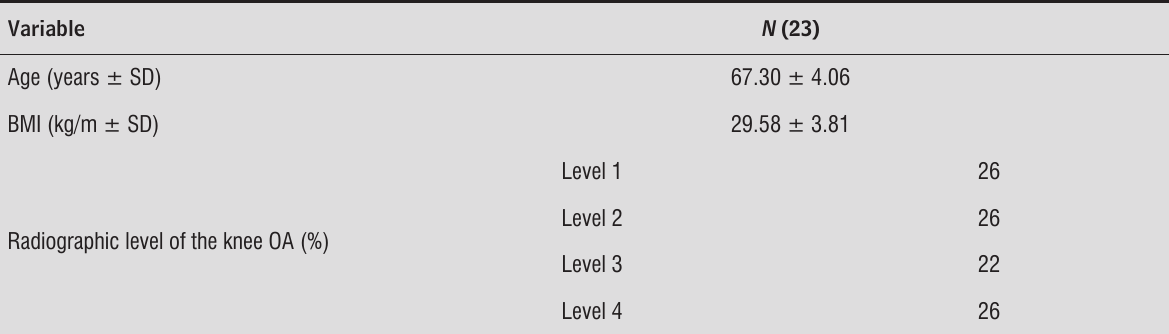
Table 1 - Characterization of the studied population